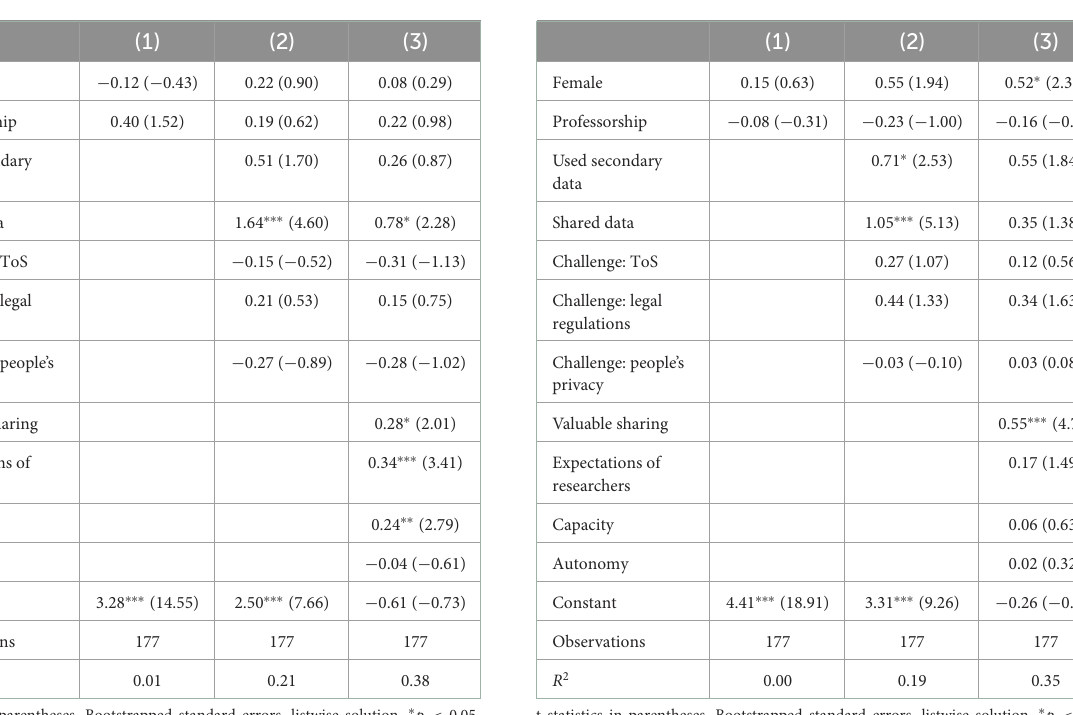
TABLE 1 Regression model to predict the intention to share data publicly.